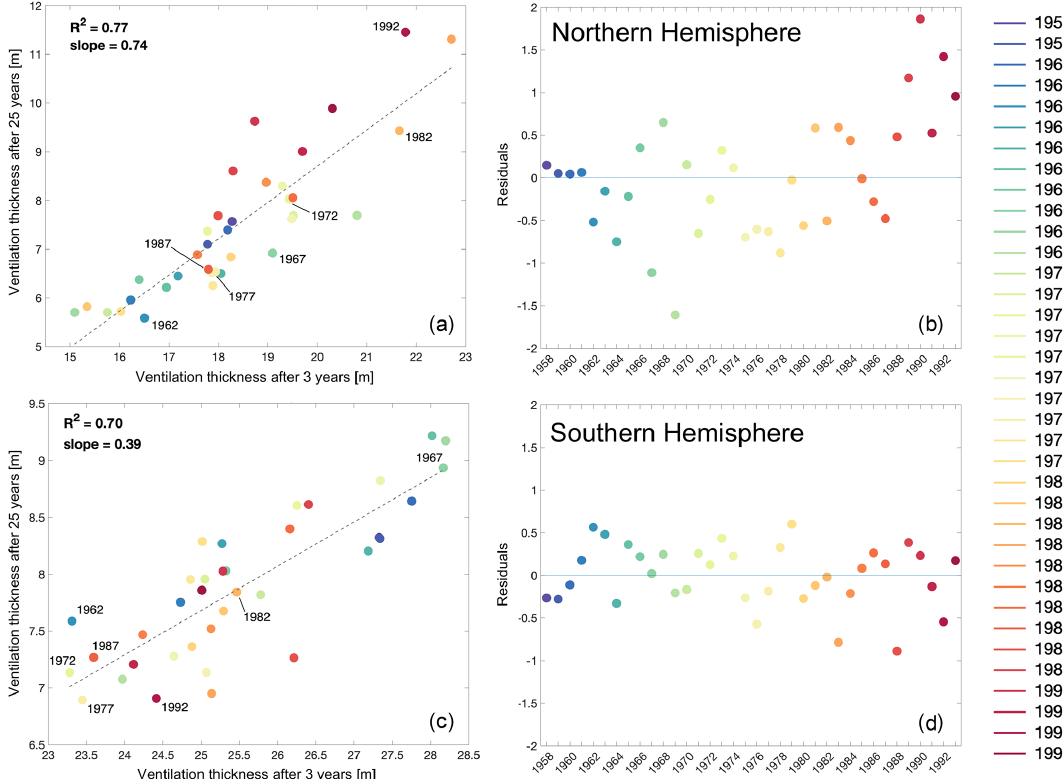
Figure 10. Correlation between ventilation thickness after 3 years and after 25 years in the Northern Hemisphere (a) and Southern Hemi- sphere (c) , and the residuals of the correlation in both hemispheres ( b , d respectively). The years of injection for the vintages shown in Fig. 9 are highlighted for both hemispheres in panels (a) and (c)